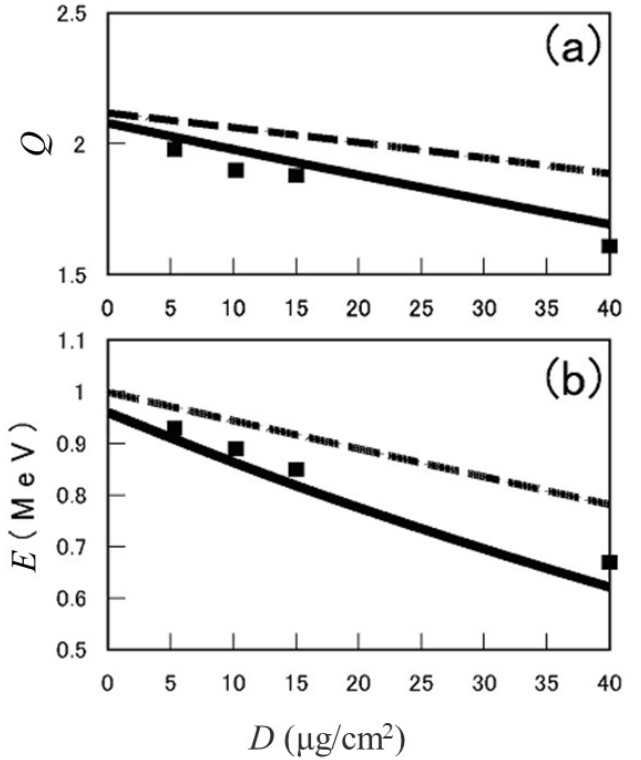
Figure 5. ( a ) Average charge Q and ( b ) kinetic energy E of 0.96 MeV C ion on carbon foil (solid line), and for 1 MeV C ion on aluminum foil (broken line) vs. foil thickness D [15]. Solid squares are the experimental data for carbon foil [51].